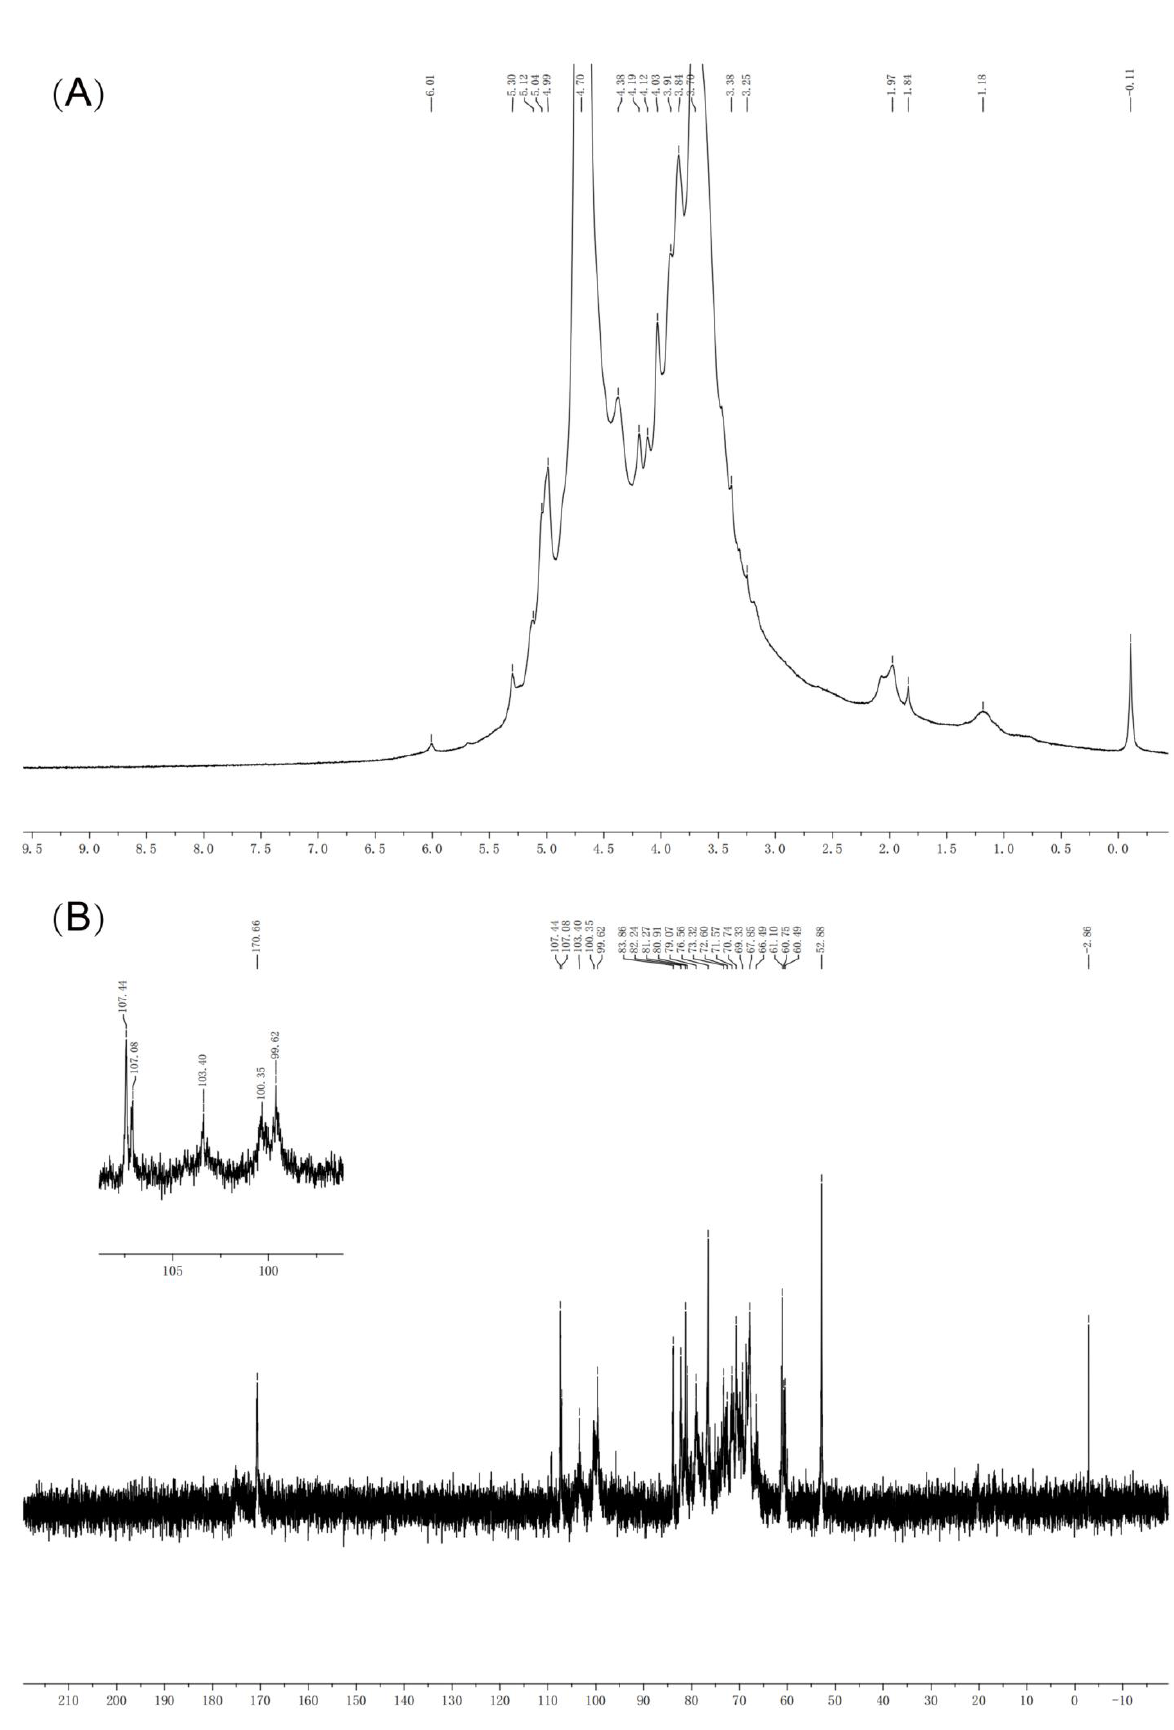
Figure 7. The 1D NMR spectrum of BCP. ( A ) 1 H spectrum; ( B ) 13 C spectrum.